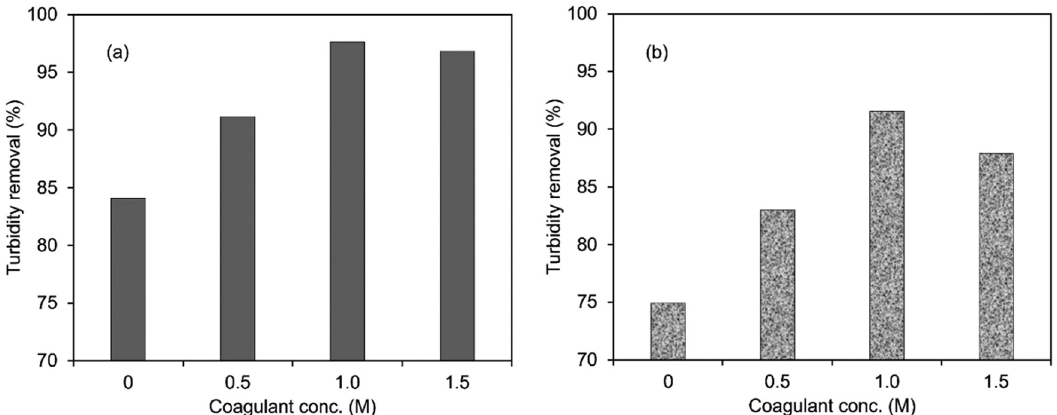
Figure 3: E ff ect of coagulant concentration on the removal of turbidity by L. leucocephala ( a ) and S. grandi fl ora ( b ) . Coagulant extraction with deionized water was indicated by initial concentration ( 0.0 M ) .